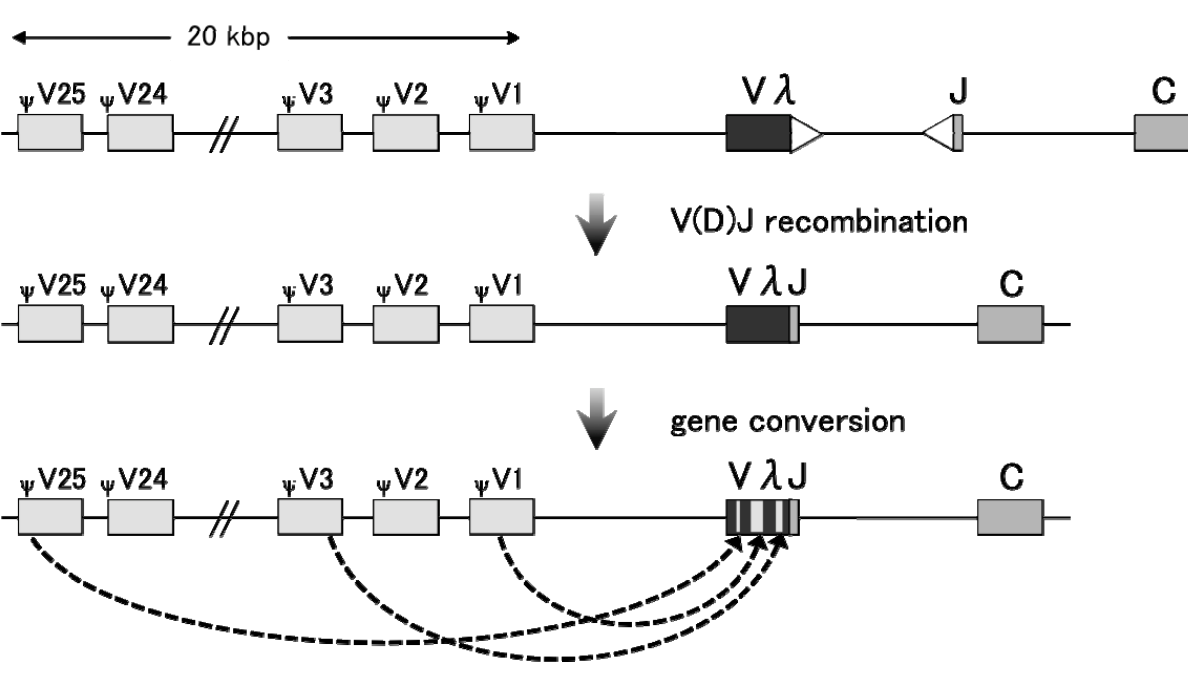
Figure 2. Organization of the chicken immunoglobulin light chain (IgL) locus. The